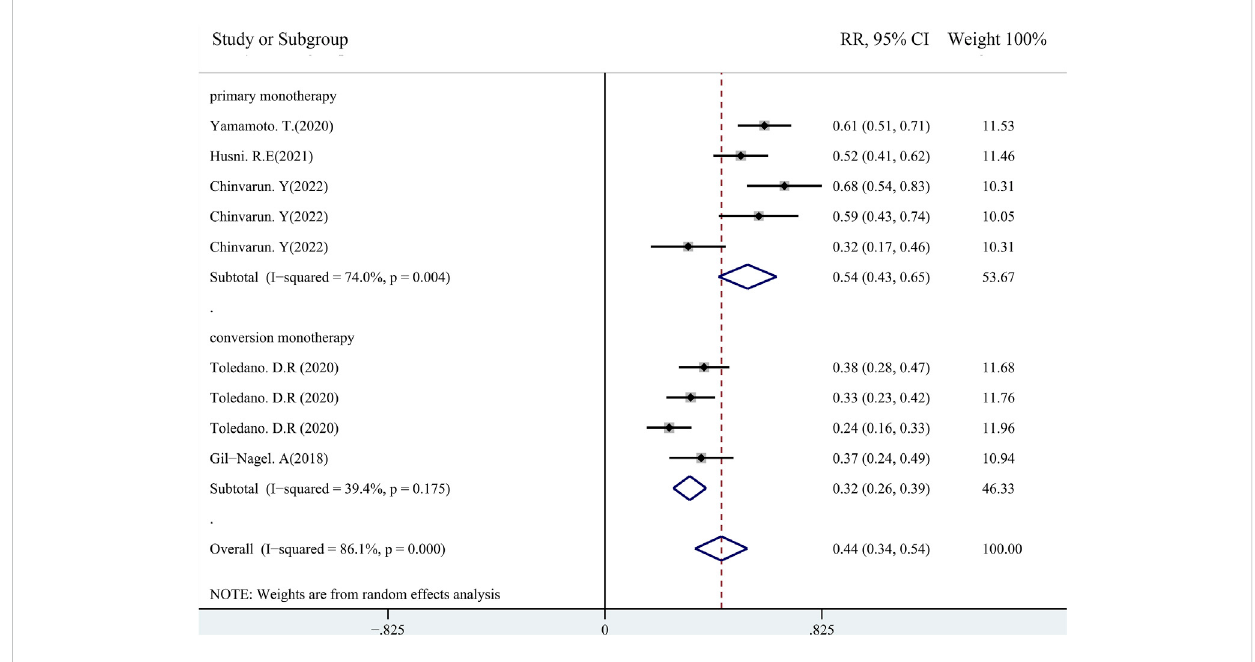
FIGURE 8 Pooled seizure-free rate (primary vs . conversion monotherapy